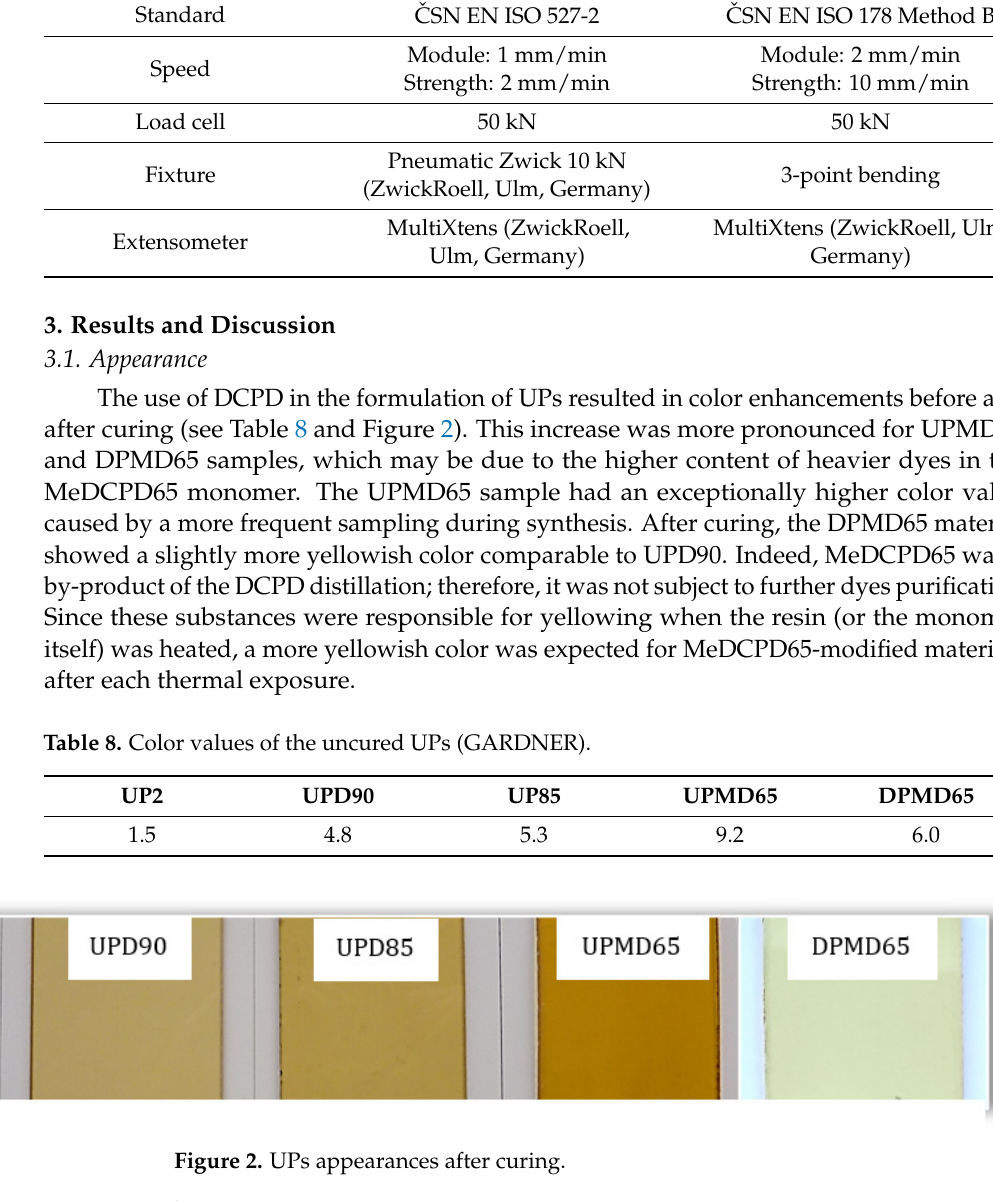
Figure 2. UPs appearances after